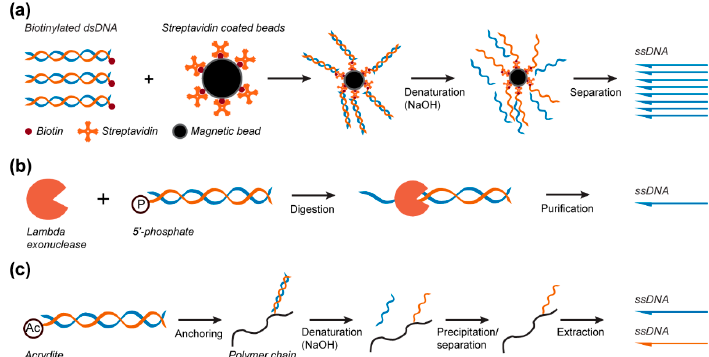
Figure 4. ssDNA scaffold production from PCR products. ( a ) A biotin-modified primer is used in PCR amplification for further biotin–streptavidin magnetic bead immobilization, dsDNA denaturation, and ssDNA separation. ( b ) Incorporation of a phosphate group in the PCR amplification allows for the subsequent generation of ssDNA sca ff olds by the preferential DNase digestion of the PCR product. ( c ) Schematic of the selective nascent polymer catch-and-release (SNAPCAR) method. In this technique, an acrydite-modified dsDNA product generated by PCR is anchored to a linear polymer chain for purification of the ssDNA sca ff olds. After separation, both ssDNA strands can be